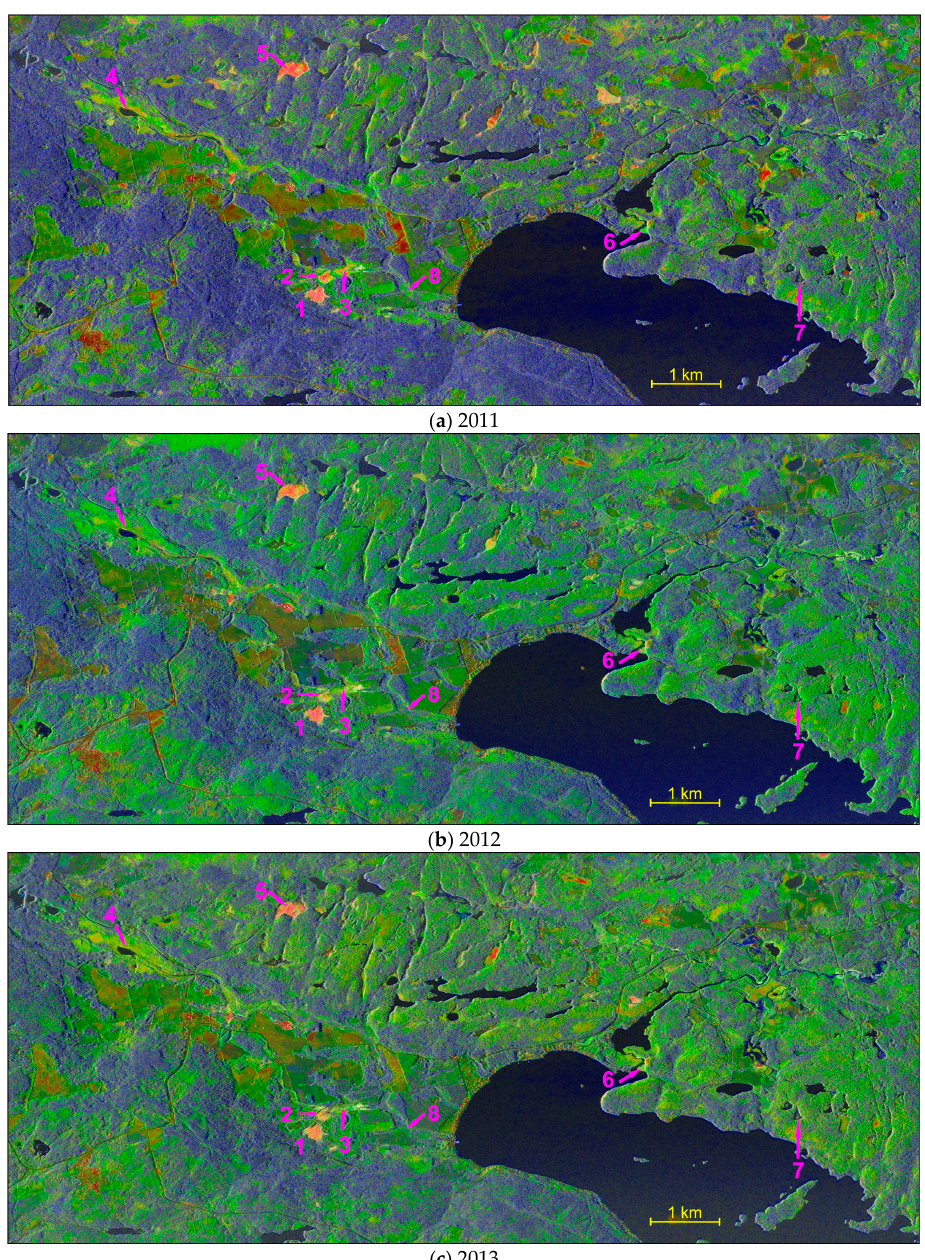
Figure 8. Example of image coherence products for the Lake Clear test site: ( a ) 2011 data; ( b ) 2012 data; ( c ) 2013 data. Wetlands of note are numbered as indicated in Section 2.2.